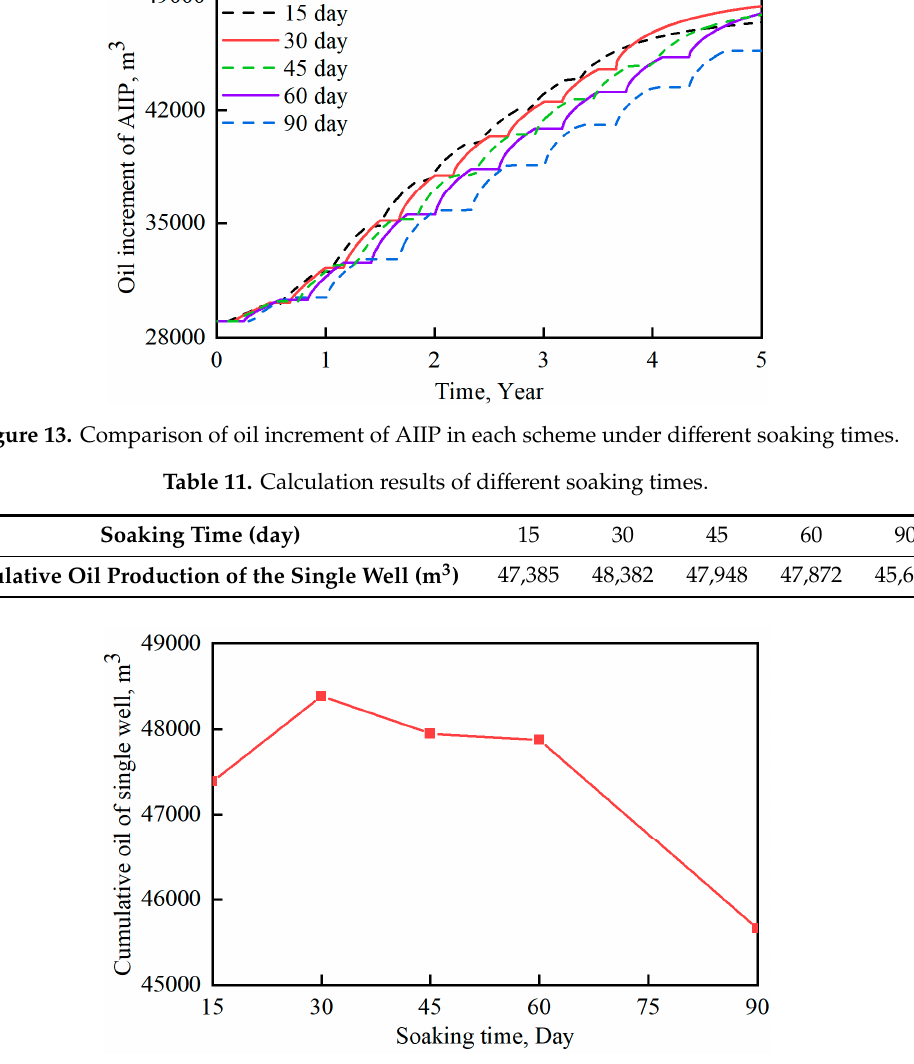
Figure 14. The relationship between cumulative oil production and soaking time in the single well.